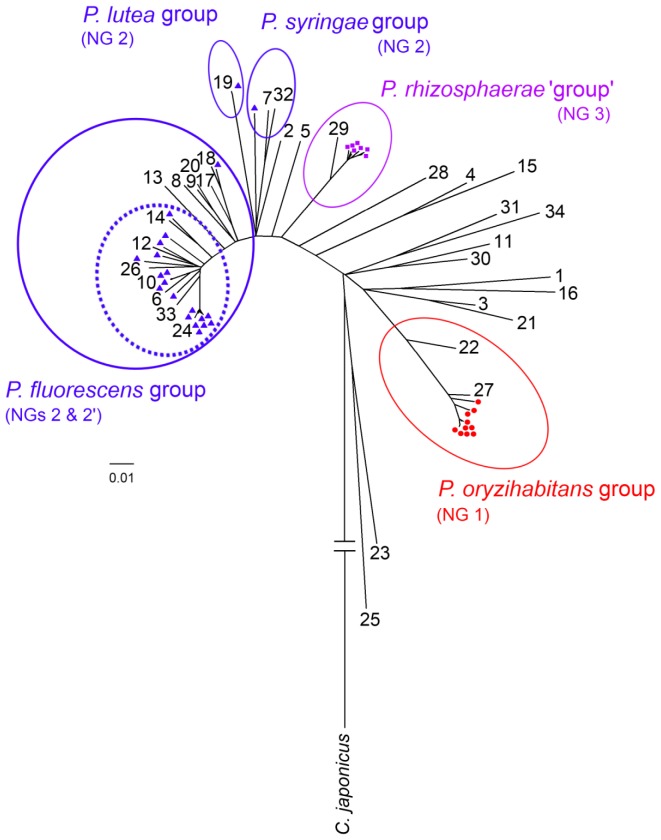
Unrooted neighbour-joining (NJ) consensus tree, based on phylogenetic analysis of concatenated (rrs + gyrB + rpoB + rpoD) sequences, displaying the relationships of nectar-inhabiting isolates (shown as red filled circles [nectar group (NG) 1], blue filled triangles [NG 2] or violet filled squares [NG 3]) and reference strains of Pseudomonas ‘sensu stricto’ species (shown as numbers, see below).Nectar isolates belonging to subgroup NG 2′ are shown within a dotted circle. Evolutionary distances were computed using the Jukes-Cantor method and are in the units of number of base substitutions per site. Cellvibrio japonicum Ueda107T was used as an outgroup. A complete version of this figure is provided as supporting information (Figure S3). Numeric codes for reference strains shown in the tree: 1, P. aeruginosa DSM 50071T; 2, P. agarici LMG 2112T; 3, P.alcaliphila AL15-21T; 4, P. anguilliseptica NCIMB 1949T; 5, P. asplenii ATCC 23835T; 6, P. azotoformans IAM 1603T; 7, P. cannabina CFBP 2341T; 8, P. chlororaphis DSM 50083T; 9, P. corrugata ATCC 29736T; 10, P. extremorientalis KMM 3447T; 11, P. flavescens B62T; 12, P. fluorescens IAM 12022T; 13, P. fragi ATCC 4973T; 14, P. gessardii CIP 105469T; 15, P. guineae LMG 24016T; 16, P. indica IMT37T; 17, P. jessenii CIP 105274T; 18, P. koreensis KACC 10848T; 19, P. lutea OK2T; 20, P. mediterranea CFBP 5447T; 21, P. oleovorans IAM 1508T; 22, P. oryzihabitans IAM 1568T; 23, P. pachastrellae KMM 330T; 24, P. palleroniana CFBP 4389T; 25, P. pertucinogena IFO 14163T; 26, P. poae DSM 14936T; 27, P. psychrotolerans C36T; 28, P. putida IAM 1236T; 29, P. rhizosphaerae IH5T; 30, P. straminea IAM 1598T; 31, P. stutzeri ATCC 17588T; 32, P. syringae NCPPB 281T; 33, P. tolaasii LMG 2342T; 34, P. xanthomarina KMM 1447T.